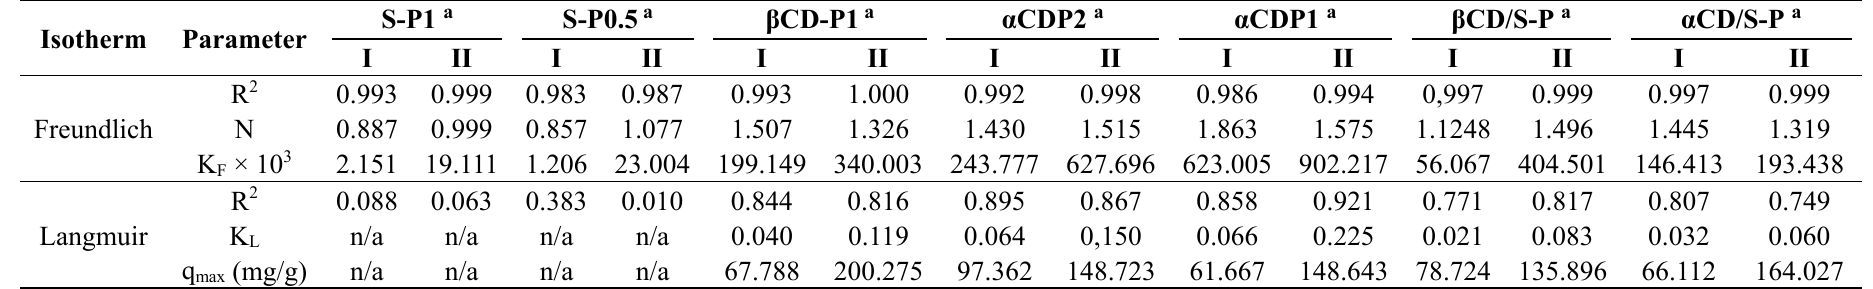
Table 3. Freundlich and Langmuir parameters for the sorption of phenol ( I ) and 4-nitrophenol ( II ) (20–5000 ppm solutions in water) on the DVS cross-linked homo- ( S-Pn and CD-Pn ) a and heteropolymers ( CDS/S-Pn ) a (100 mg). (Supplementary Material, Figures S4 and S5). Isotherm